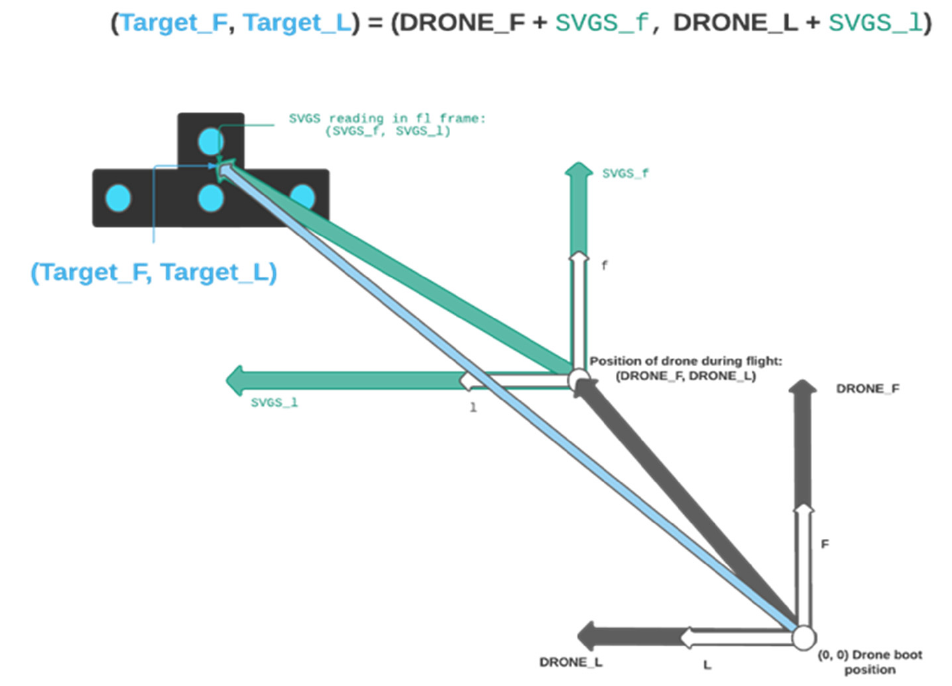
Figure 11. Estimation of the landing target position in the FLU coordinate frame.